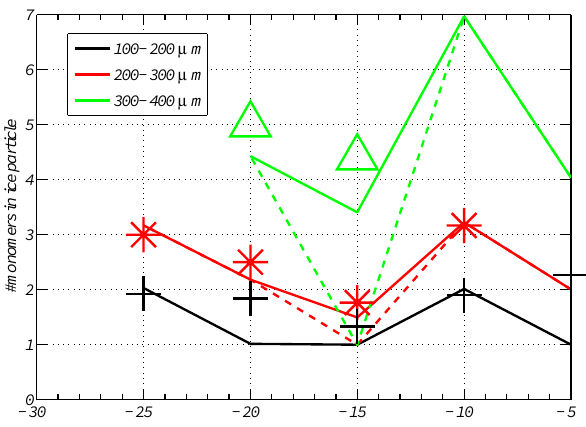
Fig. 16. A comparison of the number of monomer ice crystals in each of the size ranges: 100–200µm; 200–300µm; and 300–400µm. The solid lines are those modelled using the best guess value of E agg in Fig. 14b, while dashed lines are those modelled using the best guess value of E agg in Fig. 14a. Note that the dash black line lies on top of the black solid line because the only dif- ference between the two E agg representations are at − 15 ◦ C, where both y-values are zero. Symbols are those measured using the CPI images. Note that the E agg shown in Fig. 14a underestimates the number of monomers in all size bins at − 15 ◦ C, because the ice crystals grow too large by vapour diffusion and grow to larger sizes than the size bins